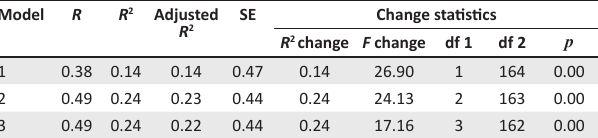
TABLE 3: Regression summary for agro-processing participation and human capital (Model 1) + TC (Model 2) + HC × TC (Model 3). Model